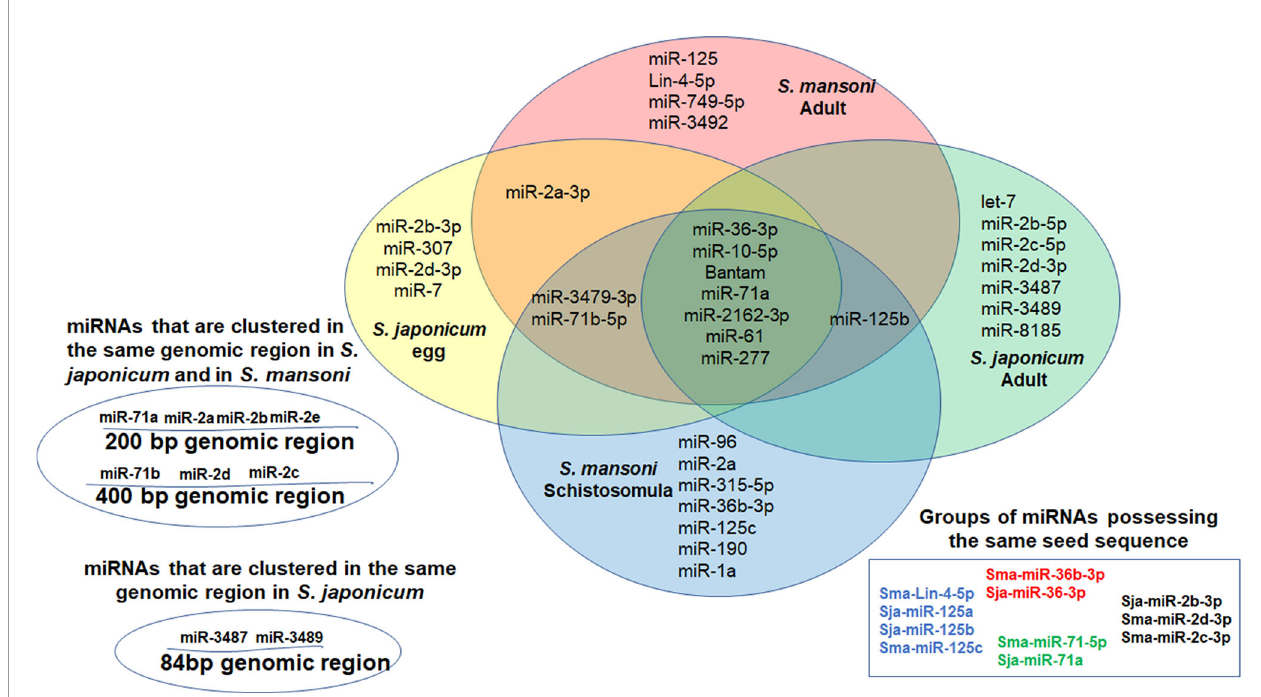
FIGURE 1 | Venn Diagram presenting miRNAs that were found in EVs derived from S. japonicum eggs (Zhu et al., 2016b), S. mansoni schistosomula (Nowacki et al., 2015) and both S. japonicum adult (Zhu et al., 2016a) and S. mansoni adult (Samoil et al., 2018). Only miRNAs that are listed in the miRBase and have more than 100 reads are